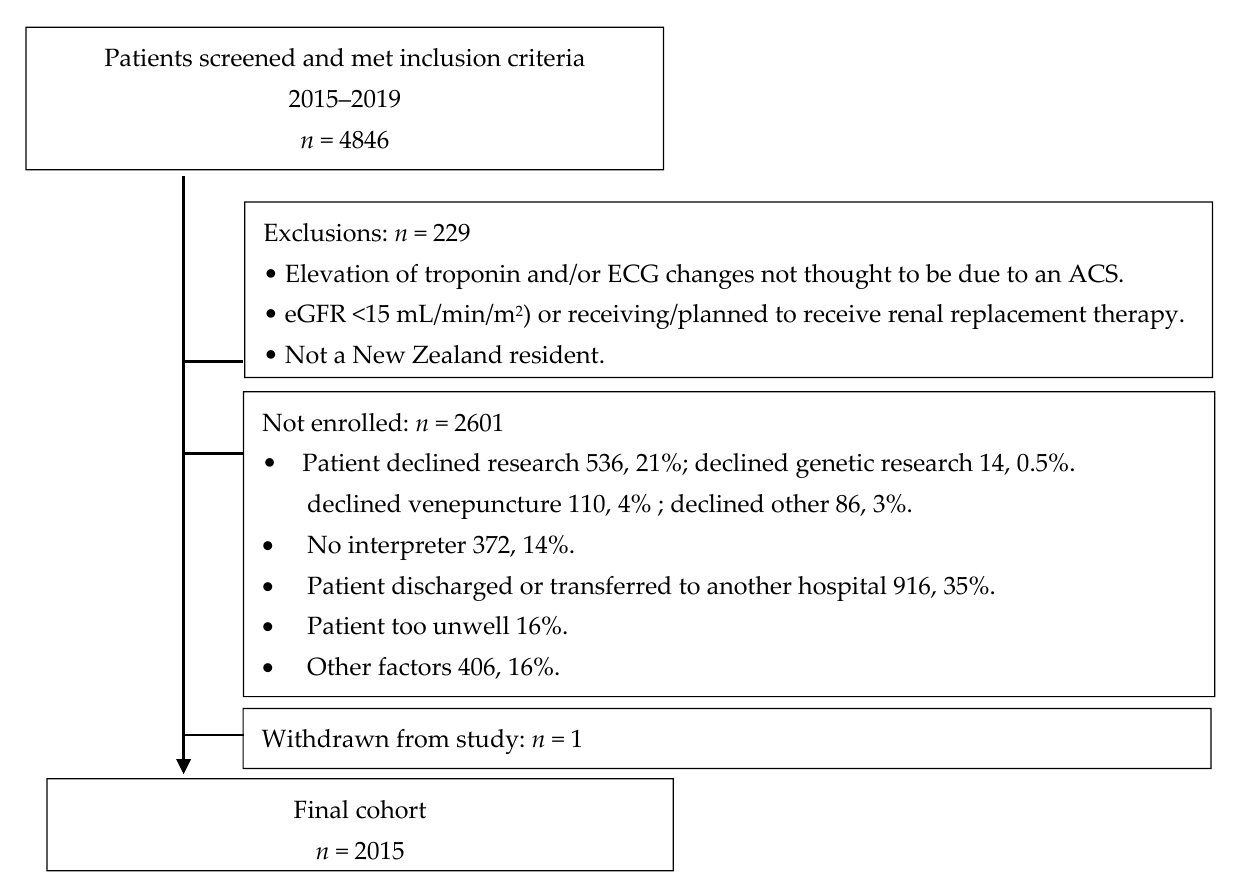
Figure 2. Flow diagram of screening and enrolment into the MENZACS.